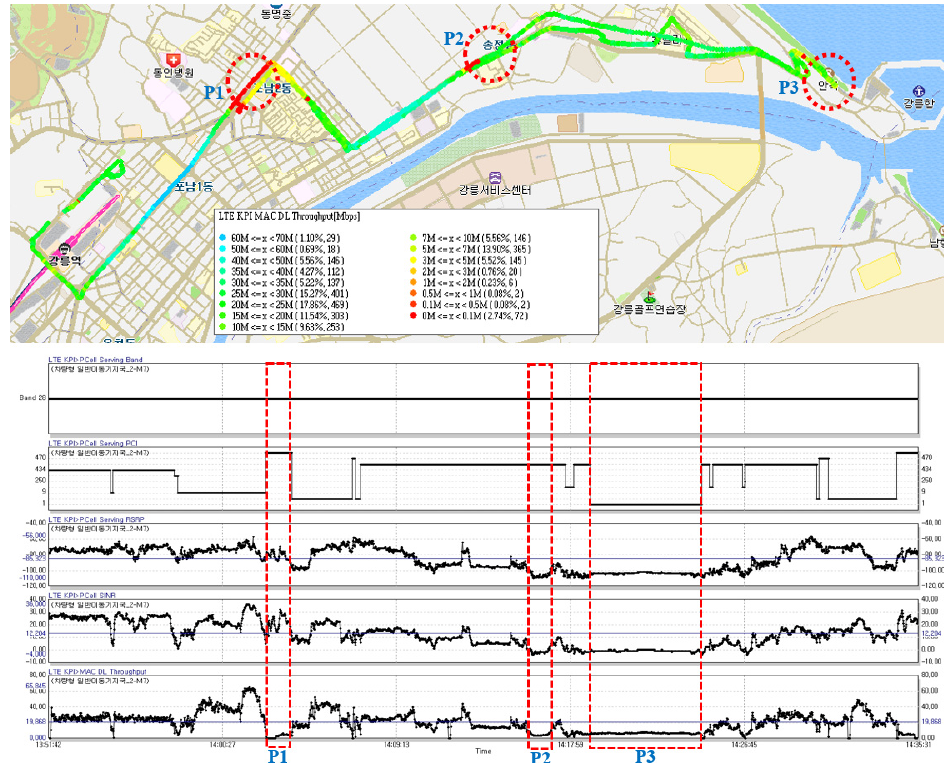
Figure 13. Download throughput